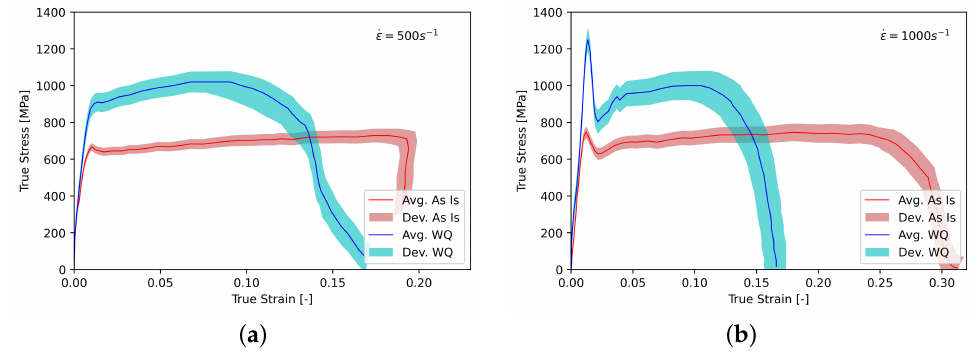
Figure 7. Hopkinson bar tests results in terms of stress over strain curves; for 500 s − 1 tested speci- mens ( a ) and 1000 s − 1 tested specimens ( b